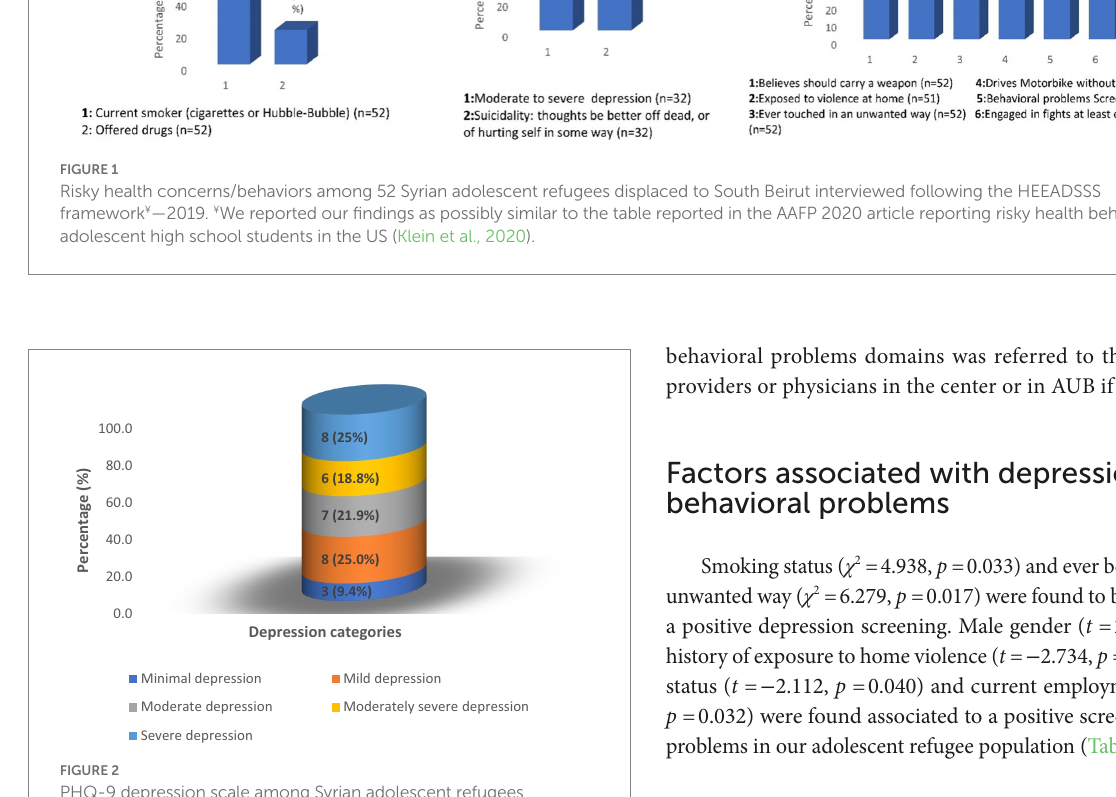
FIGURE 2 PHQ-9 depression scale among Syrian adolescent refugees displaced to South Beirut ( n =